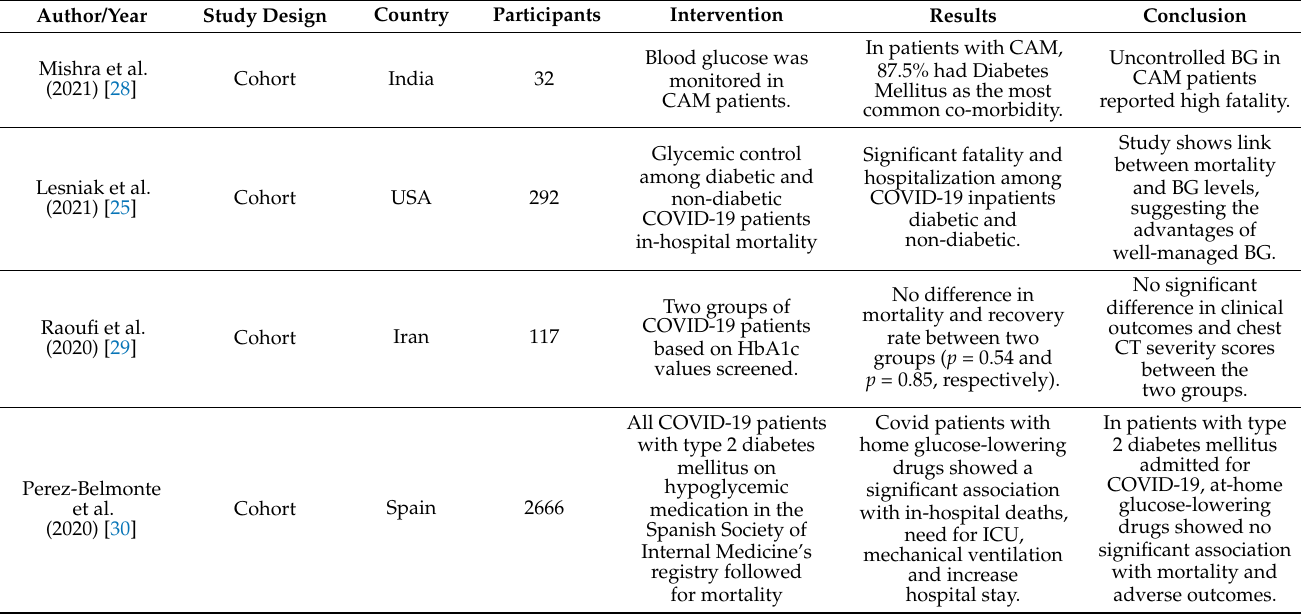
Table 1. Summary of the basic characteristics of the included